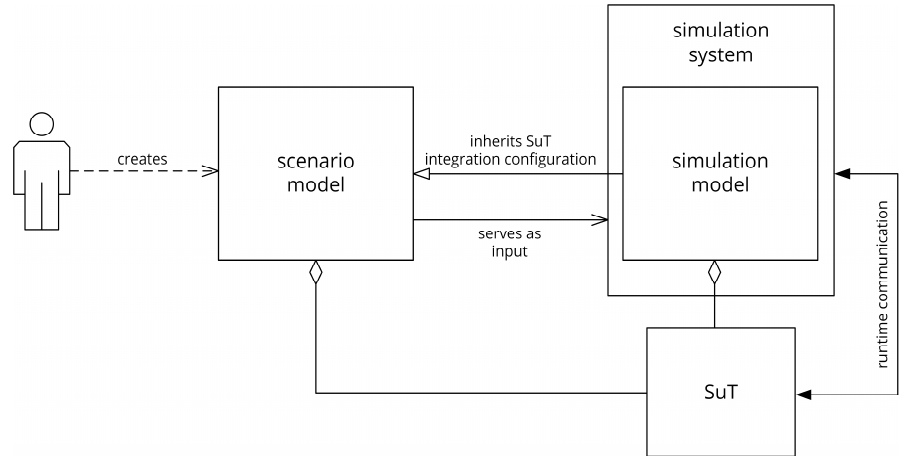
Figure 8. Integration of a SuT into the two central models of scenario-based simulation.